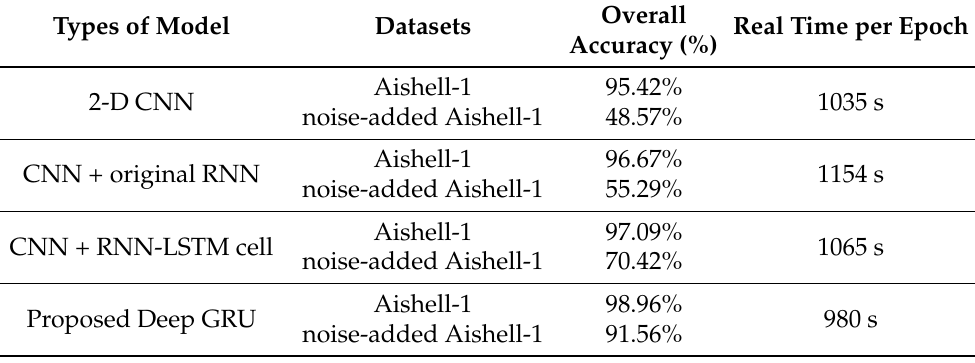
Table 2. Performance of classification accuracy of models. The noise-added Aishell-1 in Table 2 is the same as the Aishell-1 with Gaussian white noise added in Table 3, and it refers to the clean Aishell-1 dataset with Gaussian white noise added.